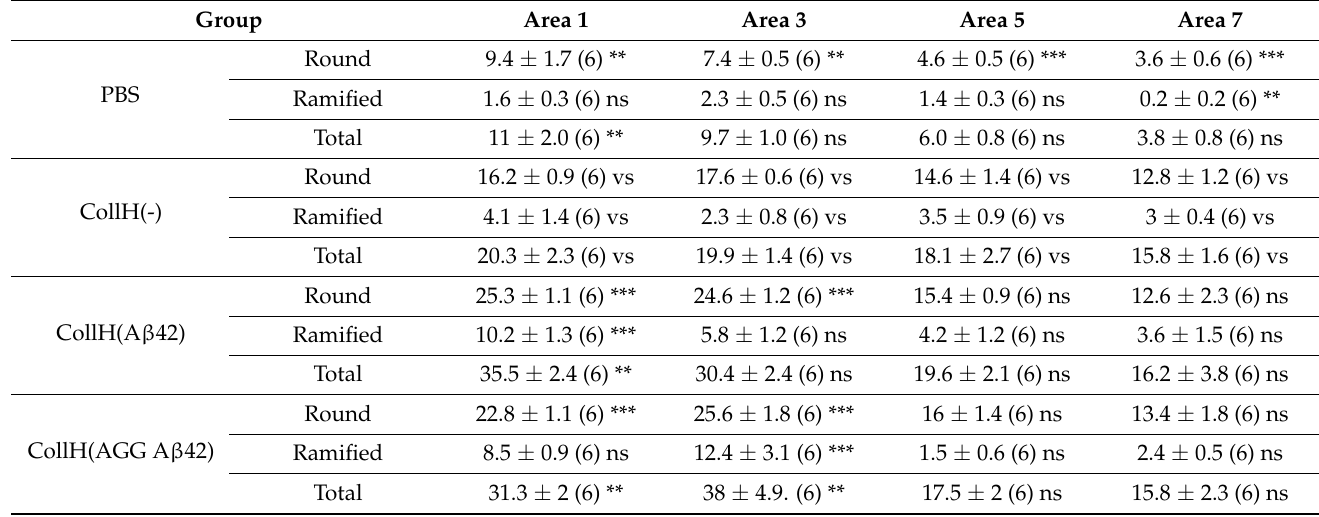
Figure 10. Microglial responses. Coronal half-brain slices were prepared and collagen hydrogels were loaded with human beta-amyloid-42 (A β 42), placed on slices taken from wildtype mice, cultured for eight weeks, fixed and stained for microglial Iba1+. Round ( A ) and ramified ( B , C ) Iba1+ microglia could be identified. Immunostaining for Iba1+ Alexa488 (green channel) was selective, as it was not seen in the red channel ( D , E ), and also staining for beta-amyloid-Alexa546 (red channel) was specific, as it was not seen in the green channel ( F , G ). Co-localization experiments with Iba1 (A488, green, H ), A β (A546, red, I ) and nuclear DAPI (blue, J ) showed that the majority of Iba1+ microglia also contained A β ( K , merged). Scale bar in A = 40 µ m ( A – C ), 65 µ m ( D – K ). Table 2. Iba1 positive microglia in organotypic brain slices after beta-amyloid